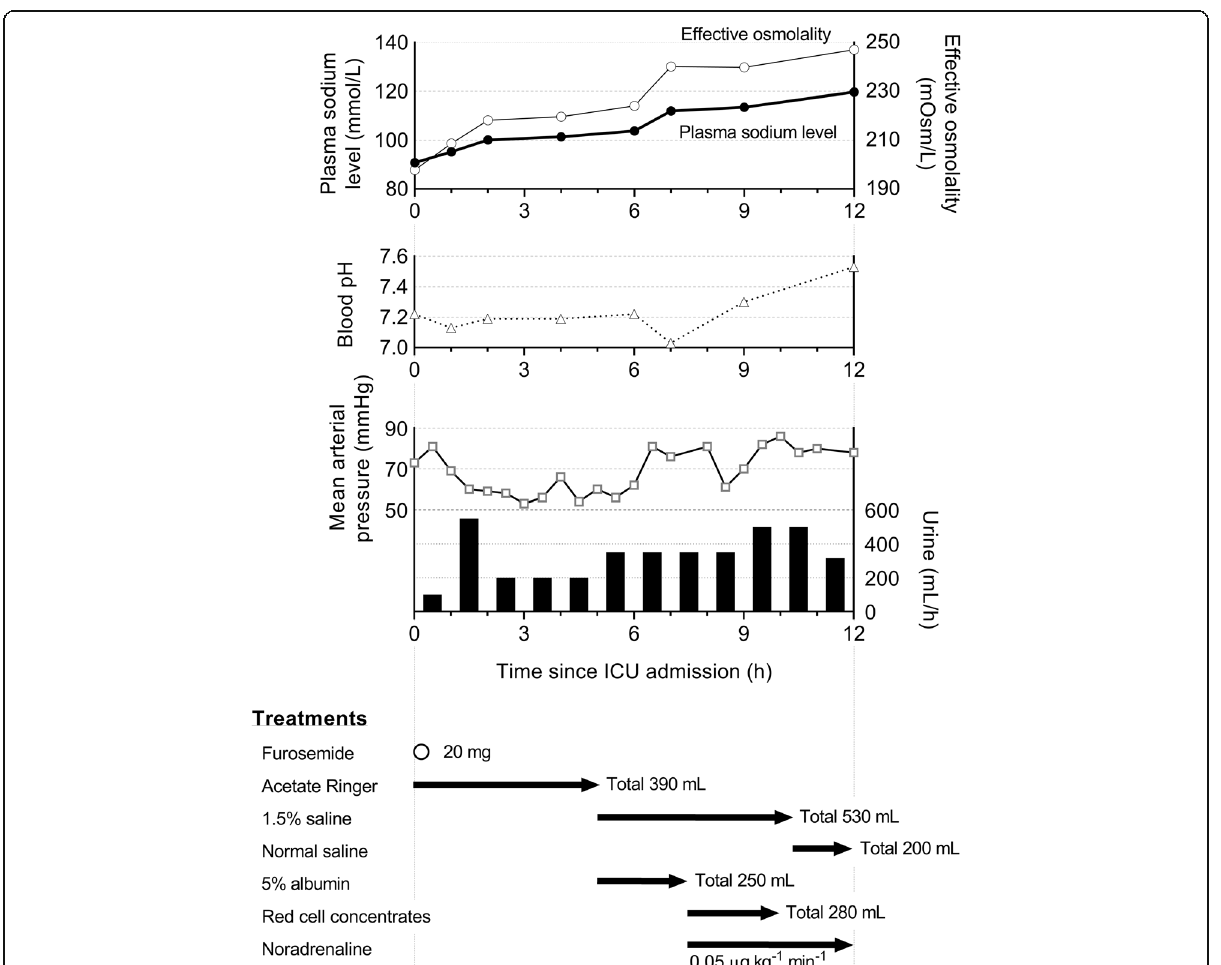
Fig. 2 Time courses of plasma sodium level, effective osmolality, blood pH, mean arterial pressure, urine output, and treatments for hyponatremia in intensive care unit. Each symbol indicates each measurement and each black bar shows hourly urine output. For the treatments, each arrow indicates the duration of the treatment, and open circle indicates the time of furosemide